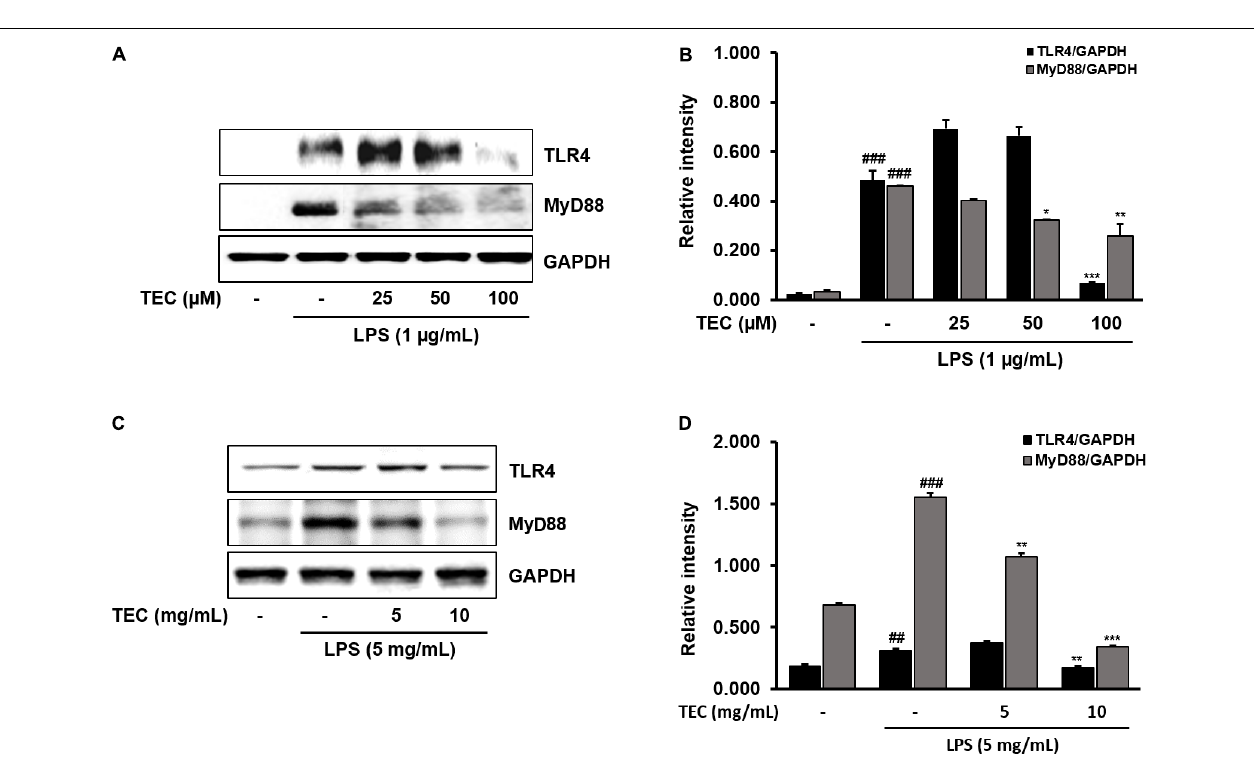
FIGURE 7 | TEC suppresses the expression of TLR4 and MyD88 in LPS-stimulated BV-2 cells and mice. (A,C) Western blotting analysis was performed to quantify the TLR4 and MyD-88 in BV-2 cells and murin hippocampus tissues. (B,D) Band intensities were quantified by densitometric analysis and normalized by GAPDH. ## P < 0.01 or ### P < 0.001 vs. untreated cells and mice and ∗ P < 0.05, ∗∗ P < 0.01, or ∗∗∗ P < 0.001 vs. LPS-treated cells and mice,